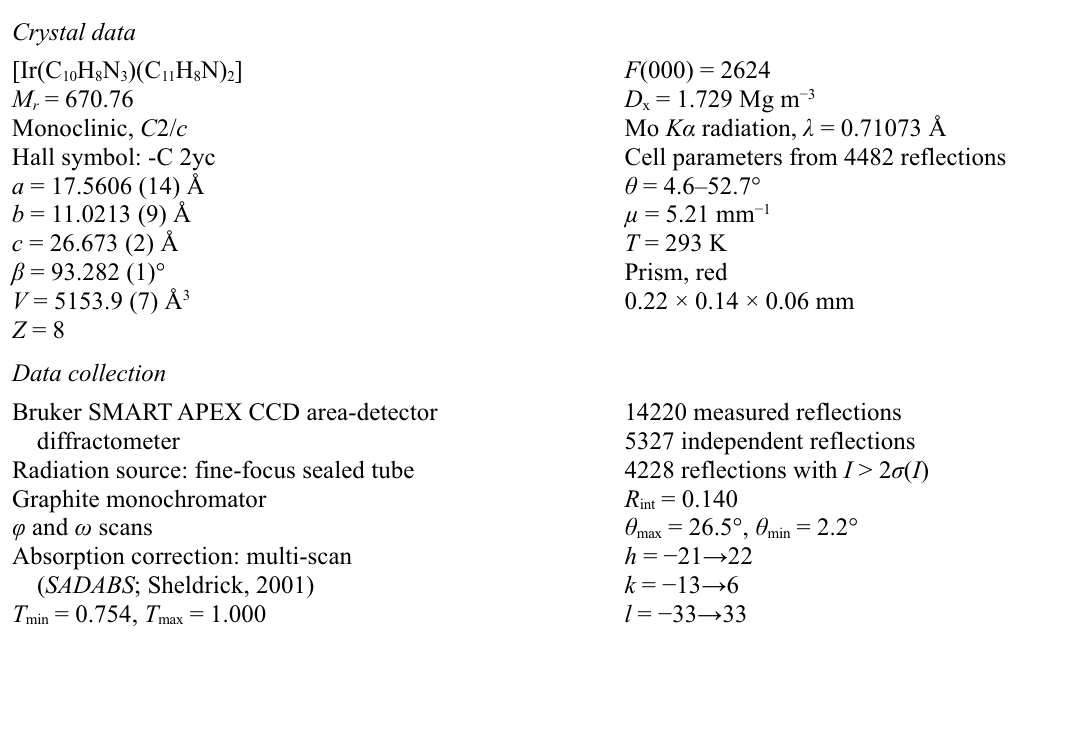
Figure 1 The structure of (I), showing 50% probability displacement ellipsoids and the atom-numbering scheme.